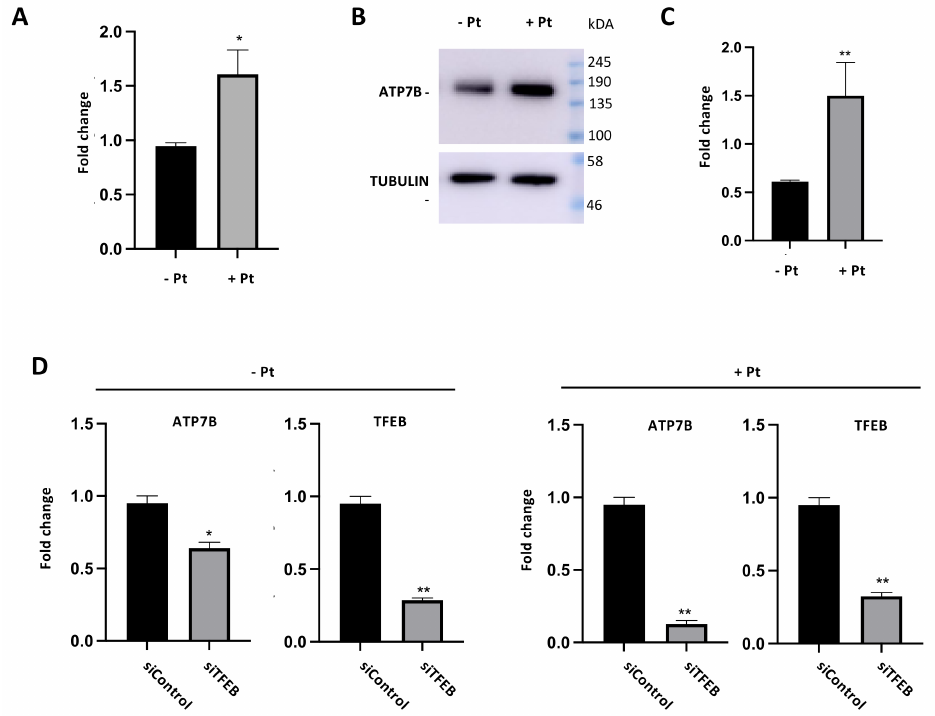
Figure 3. Cisplatin and TFEB impact on ATP7B expression in resistant cells. ( A – C ) ATP7B mRNA ( A ) and protein levels ( B and quantification in C ) were increased in IGROV-CP20 cells treated with 50 uM Pt compared to the untreated condition (**, p < 0.01; *, p < 0.05, t -test; n = 3 experiments). ( D ) RT-qPCR analysis shows a decrease in ATP7B expression levels upon silencing of TFEB (siTFEB) compared to scramble siRNA control (siControl) (**, p < 0.01; *, p < 0.05, t -test; n = 3